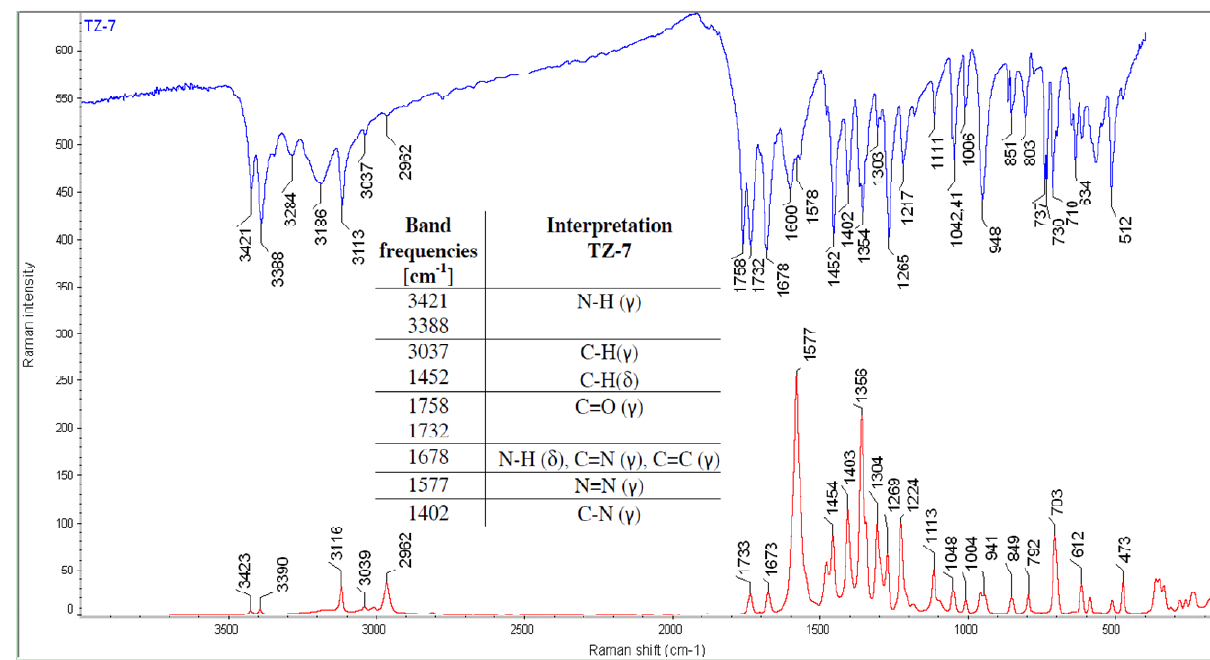
Figure 1. IR and Raman spectra of TZ-7 .